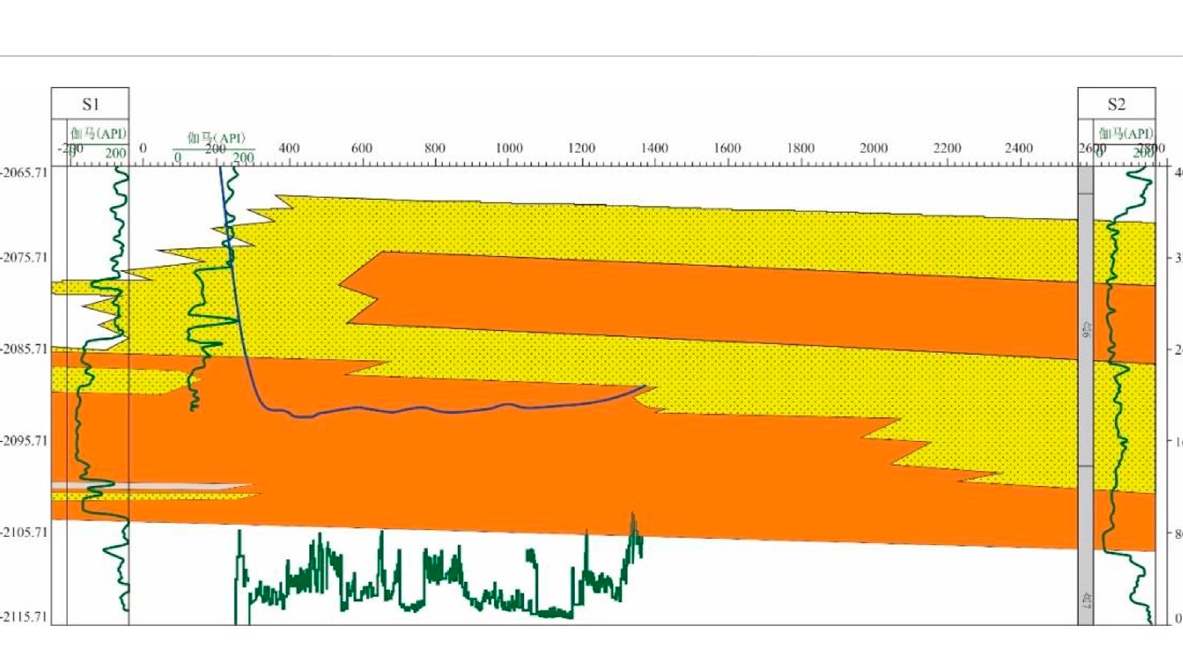
FIGURE 4 Typical section of a horizontal well in a class I